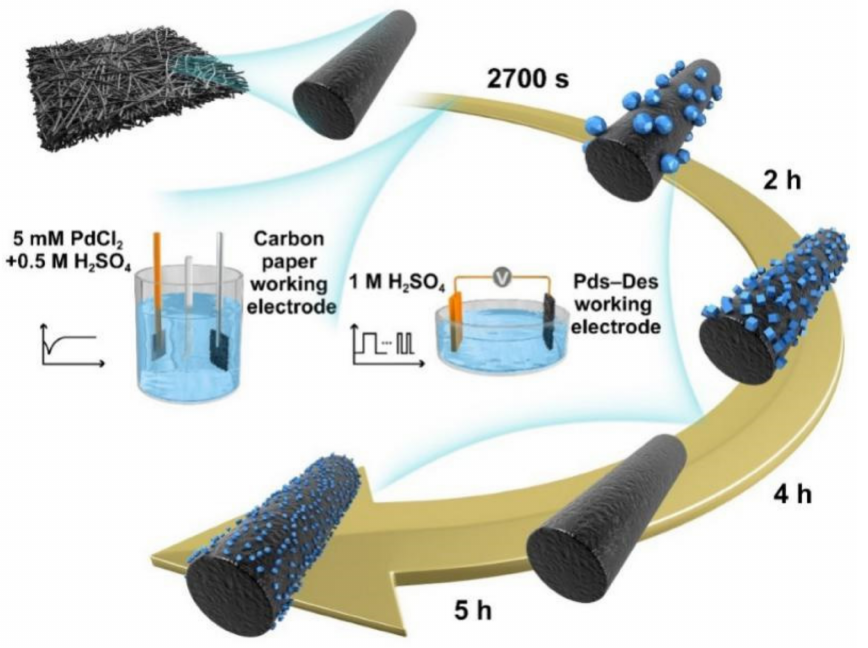
Figure 4. Schematic diagram of generation of